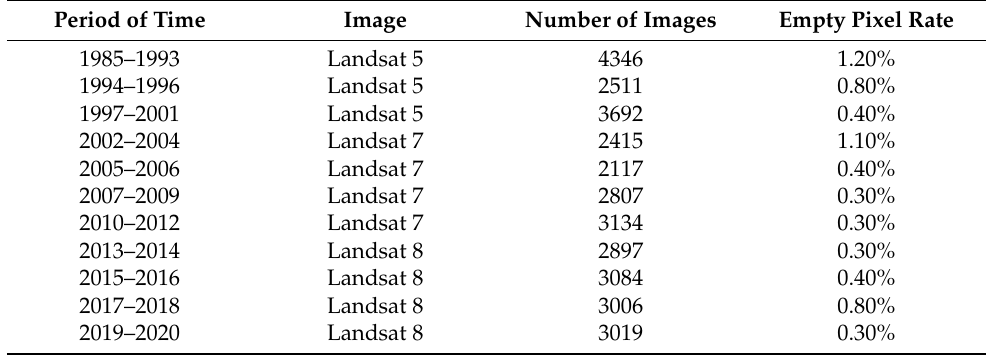
Figure 3. The process of cloud filtering and image synthesis. Table 1. Results for time periods.